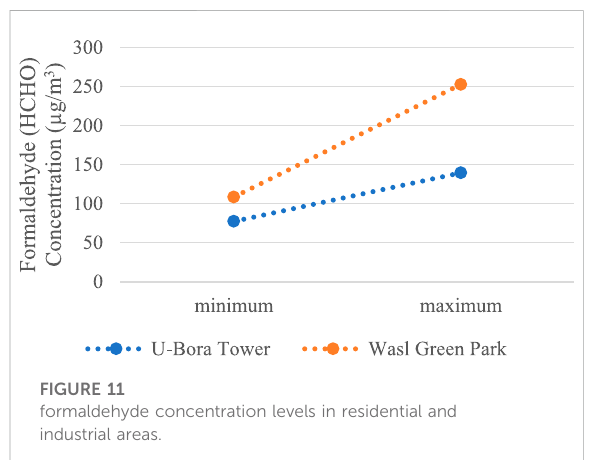
FIGURE 11 formaldehyde concentration levels in residential and industrial areas.